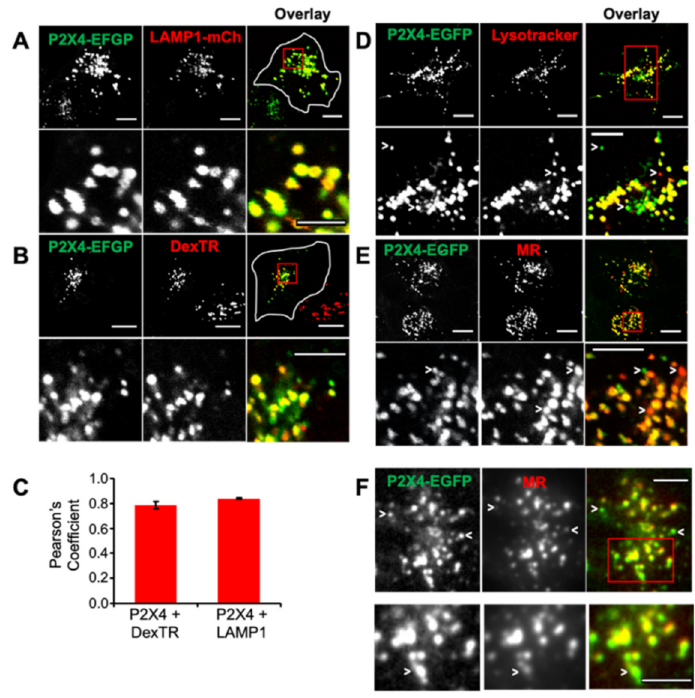
Figure 1. Colocalization of P2X4 receptors with endolysosomal markers. rP2X4-EGFP receptors were expressed in NRK cells, and live cells were imaged by confocal fluorescence microscopy 48 h post transfection after co-labeling lysosomes with a variety of different markers. These include ( A ) LAMP1- mCherry (LAMP1-mCh), which was co-transfected with rP2X4-EGFP, and ( B ) Texas Red-labeled Dextran (DexTR) incubated for 5 h and chased for 2 h at 37 ◦ C. ( C ) Calculation of Pearson’s coefficient showed the high degree of colocalization between rP2X4 and LAMP1-mCh/DexTR. Results are the mean ± SEM from three independent experiments, total number of cells, n = 40. ( D ) Cells were incubated with Lysotracker (50 nM) for 10 min at 37 ◦ C and, in ( E , F ), with a fluorescent substrate of cathepsin B, Magic Red TM (MR) for 5 min. Cells in ( F ) were imaged using TIRF microscopy to show only those rP2X4- and MR-positive compartments located within ~100 nm of the plasma membrane. Arrowheads indicate examples of compartments that are labeled only by rP2X4 or MR. Scale bars are 10 µ m (5 µ m for